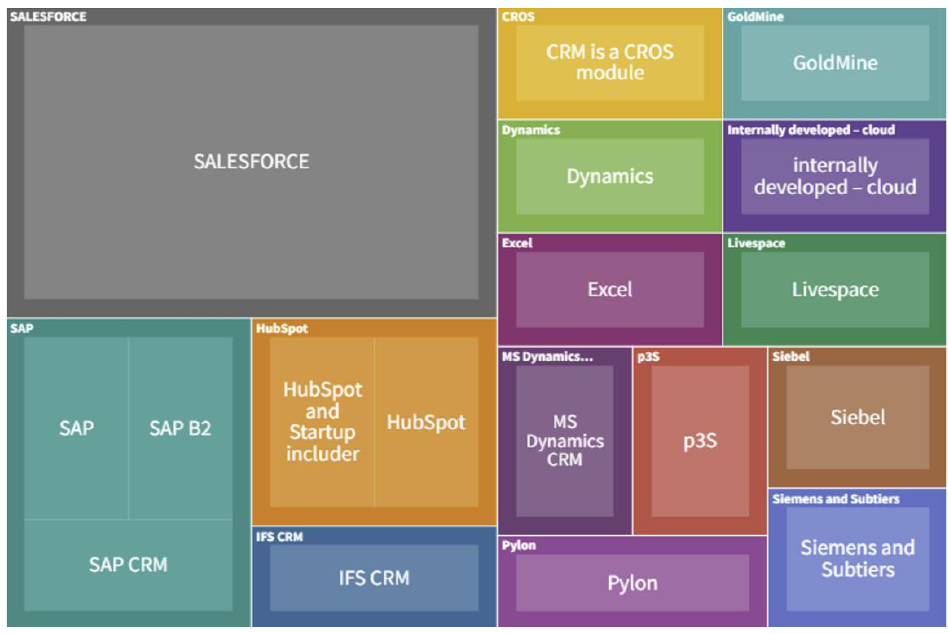
Figure 13. CRM systems implemented in the companies.